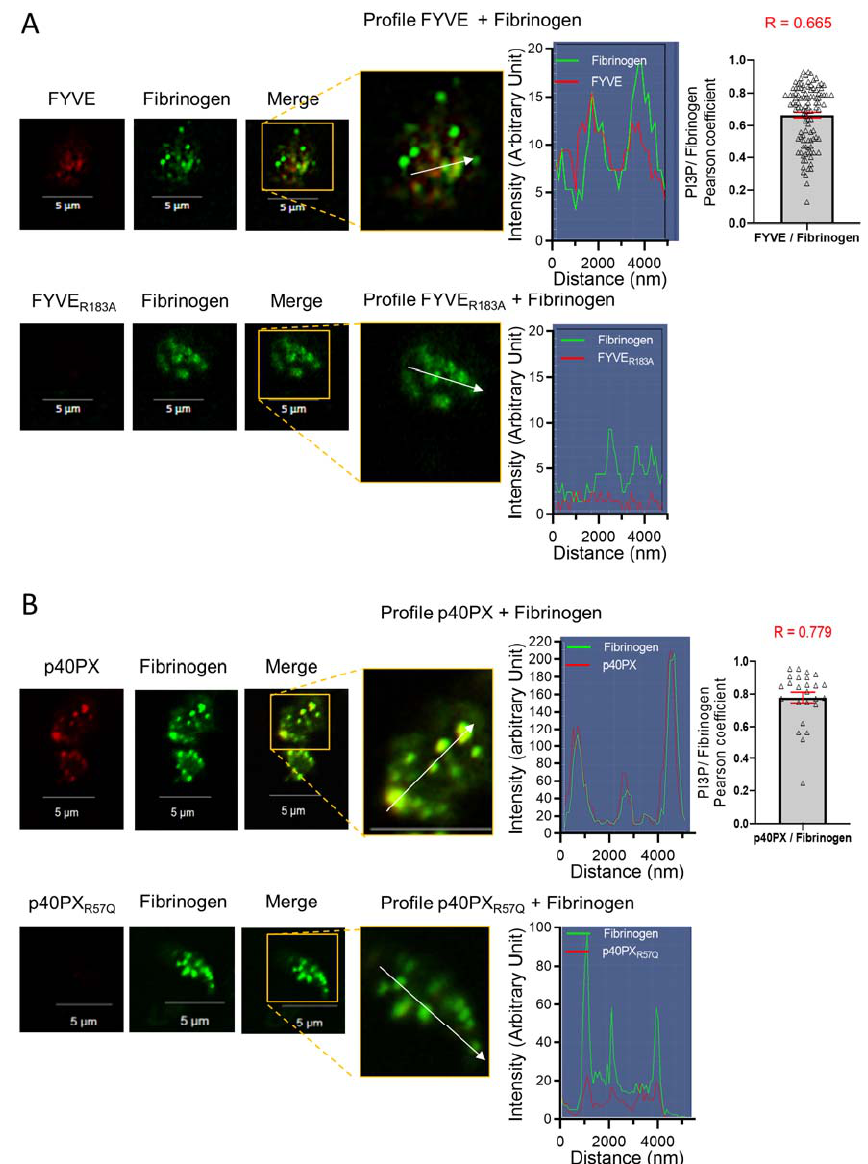
Figure 7. Exogenous PI3P-binding domains are endocytosed by platelets and accumulate in α - granules. Washed resting human platelets were incubated at 37 ◦ C for 30 min with the FYVE probe or its mutant FYVE R183A ( A ), as well as the p40PX probe and its mutant p40PX R57Q ( B ), before addition of OregonGreen fibrinogen (green), a well-established α -granules marker, for another 30 min. The colocalization of PI3P and fibrinogen is shown in yellow on the merge channel and was measured using the Pearson coefficient (R) in ImageJ software (from 106 and 26 platelets for FYVE and PX probes, respectively). The linescans (right panels) show the distribution of fluorescence along the white arrow. These images are representative of 3 independent